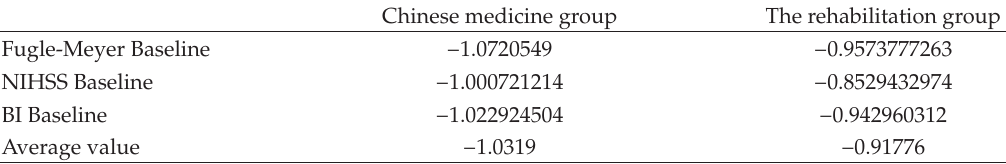
Table 1: E ffi cacy and cost e ff ectiveness of the fractal dimension of unit table. Chinese medicine group The rehabilitation